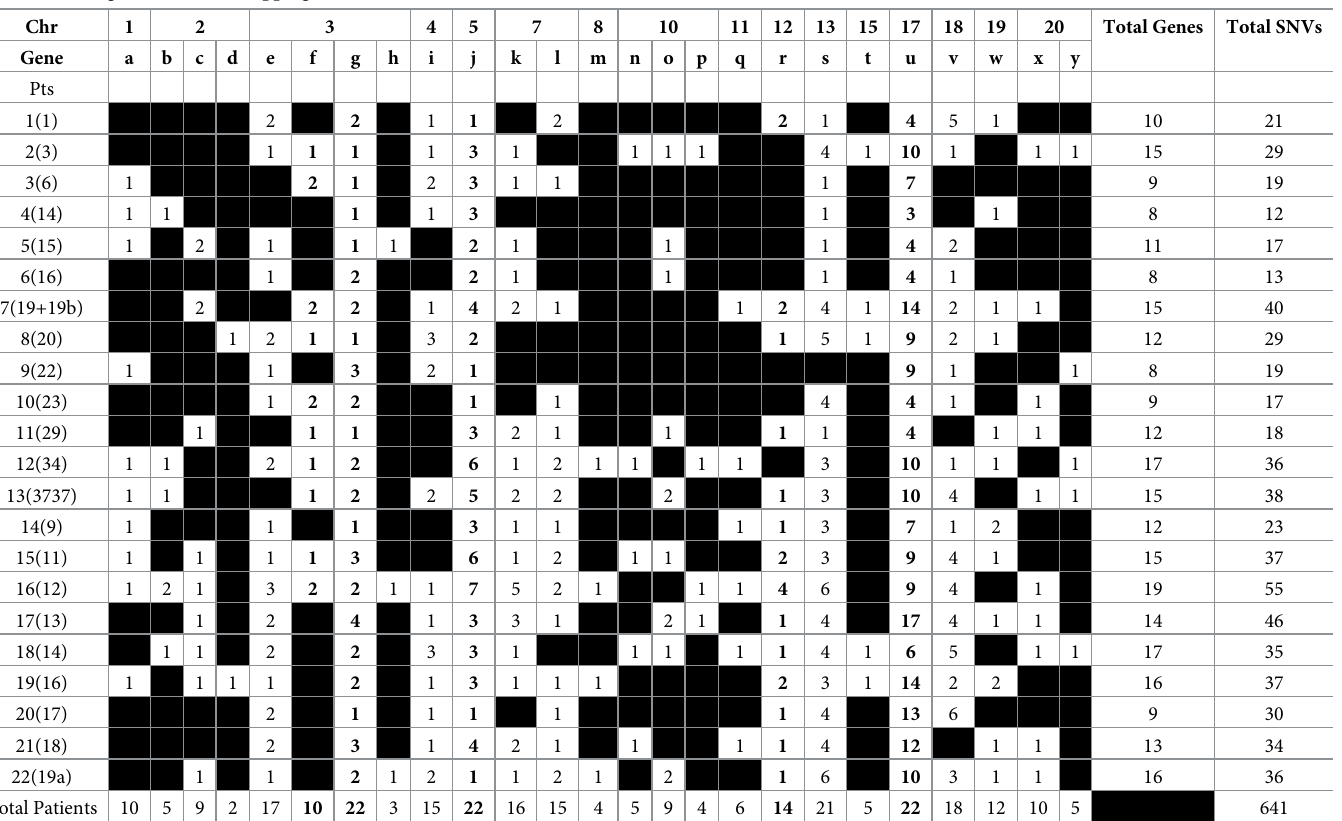
Table 1. Pathogenic mutation mapping.